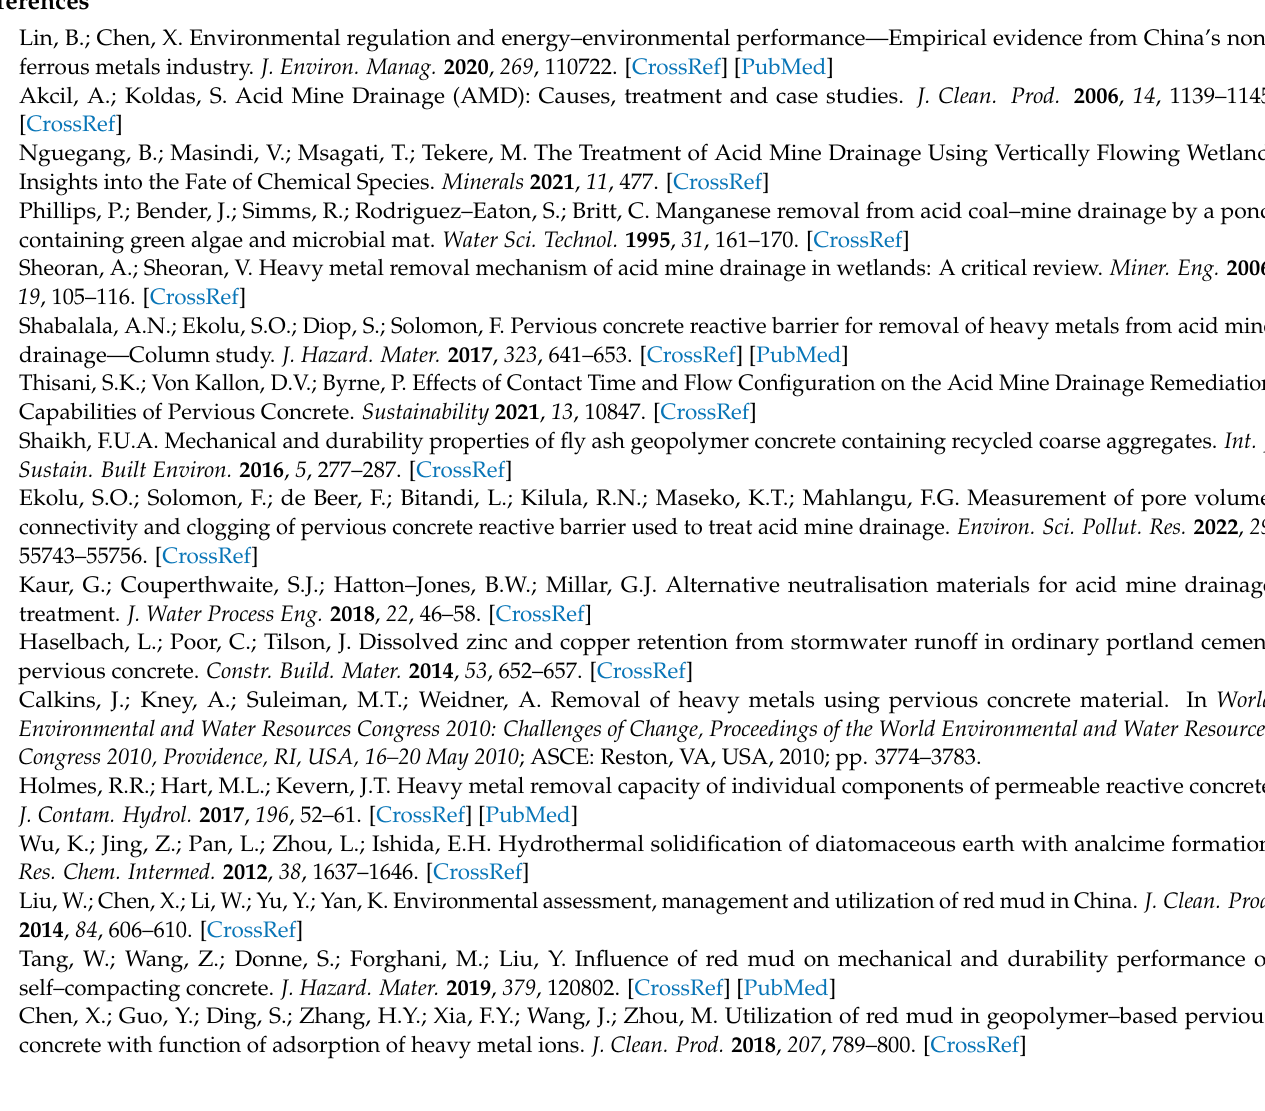
Figure S1. Variation of pH value in heavy metals removal experiment. Figure S2. Changes in Cd, Mn, Cu and Zn concentrations, and pH with time during long-term operation. Figure S3. SEM photo of raw RMPC before